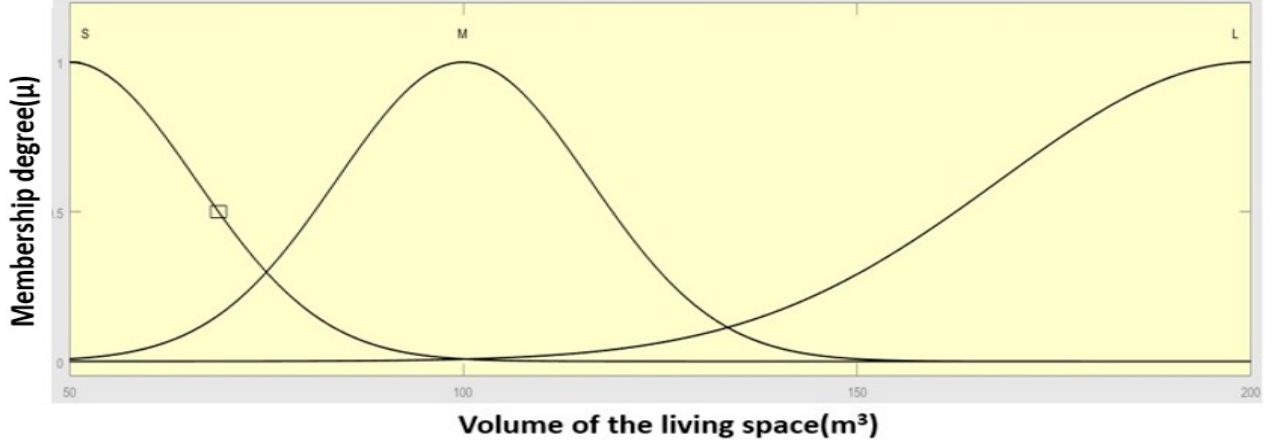
Figure 10. Membership functions of the volume of the living space ( V LS ). S: small, M: medium, and L: large.